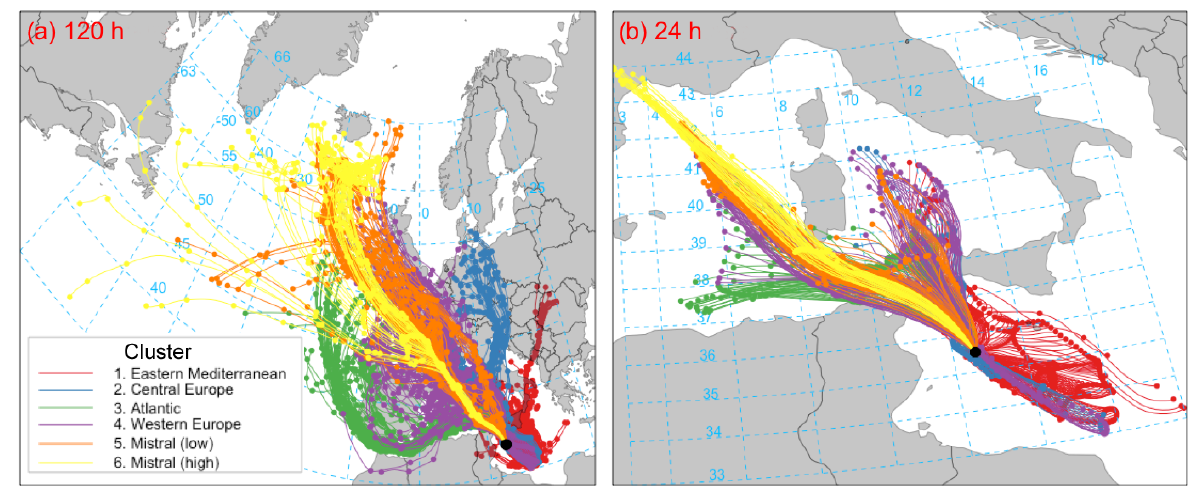
Figure 2. (a) Hourly 144h (6d) back trajectories from Lampedusa from 10 June to 5 July 2013, cut off at 120h (5d). Colours represent the assigned cluster. (b) The same as panel (a) but cut off at 24h.